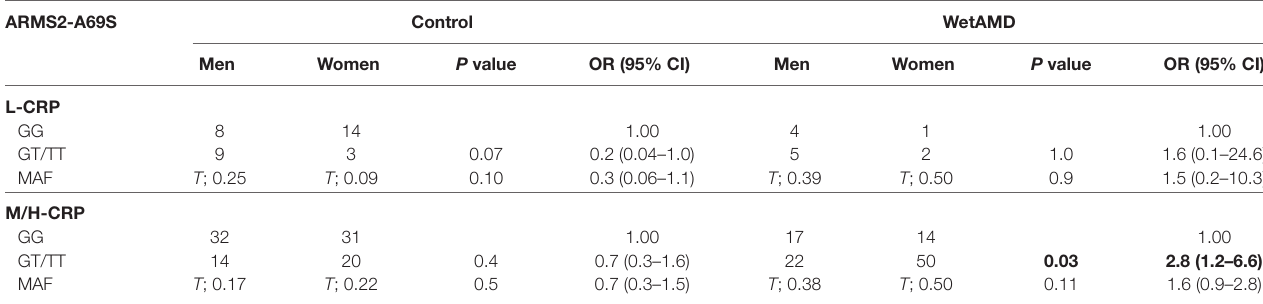
Table 6 | Dominant model of the frequencies observed for the ARMS2 A69S genotype within CRP groups between control and wetAMD in men and women separately.